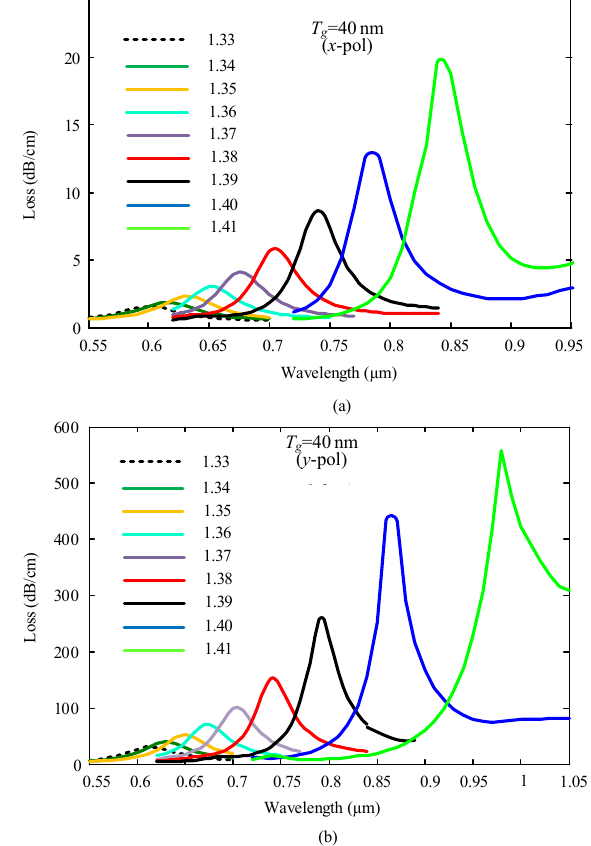
Fig. 5 Loss spectra as a function of wavelength for different analyte RIs for: (a) x- and (b) y- polarized